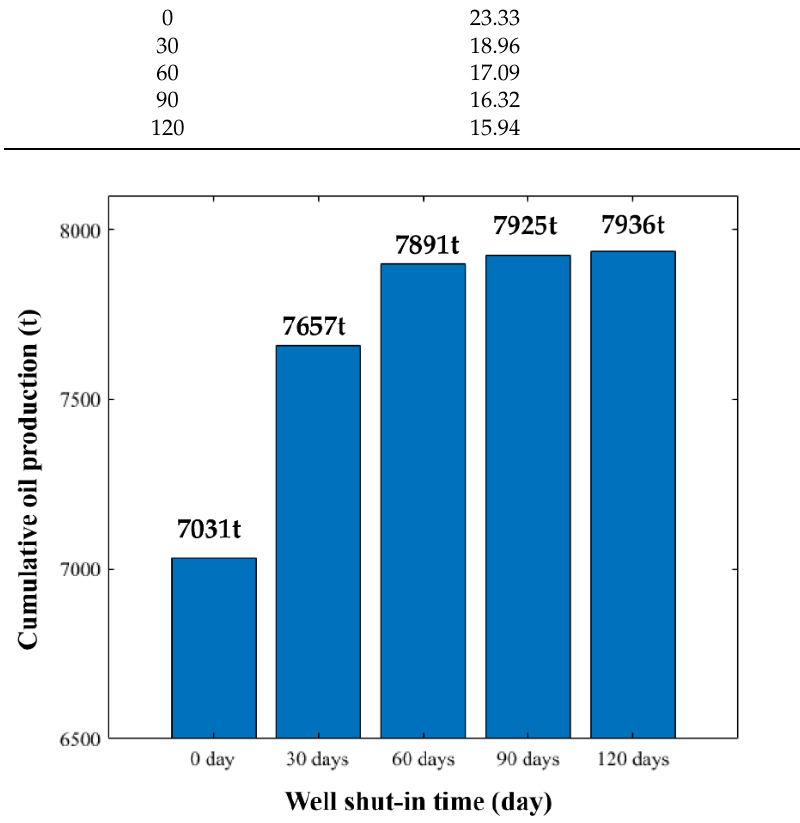
Figure 10. Comparing cumulative oil production rates after 1000 days for different shut-in times.